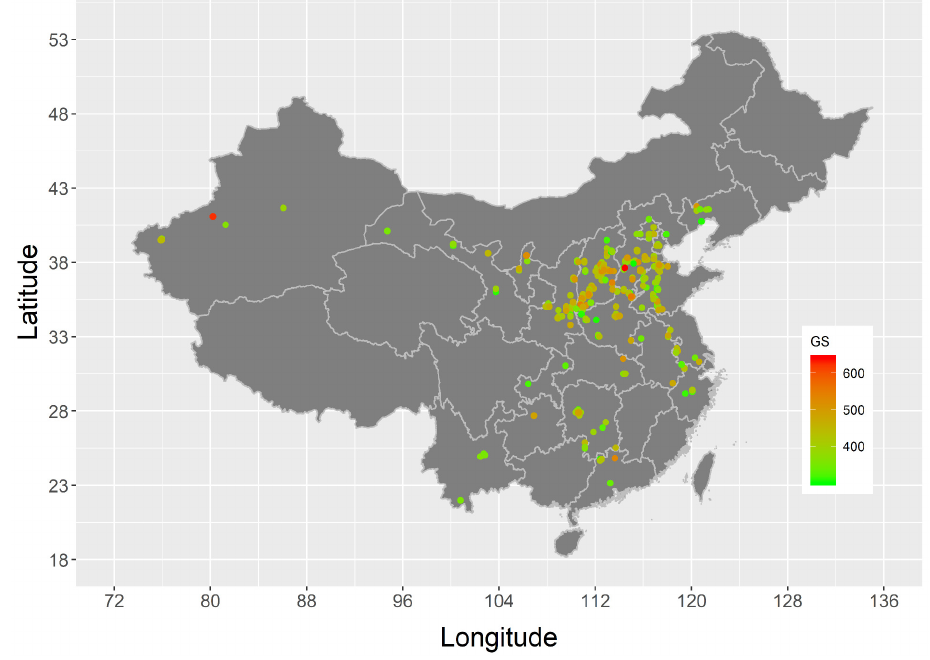
Figure 5. Geographic distribution of genome sizes of Chinese jujube cultivars. GS: genome size (Mb). The names and areas of the province correspond to the same areas shown in Figure 4.